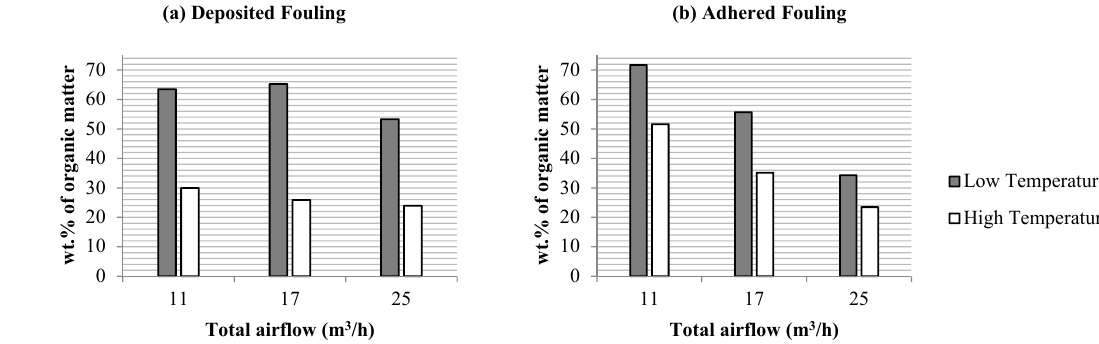
Figure 7. Organic matter content of deposited fouling ( a ) and adhered fouling ( b